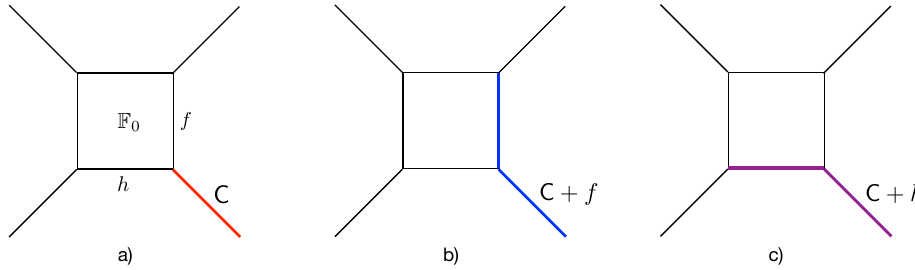
Figure 1 . Geometric realization of Wilson loop states in a Hirzebruch surface F 0 for the SU(2) gauge theory at θ = 0 on the Coulomb branch. Red, blue and purple lines in a), b), and c) correspond to BPS bound states to the Wilson loop with U(1) electric charges − 1 , +1 , +1 respectively.